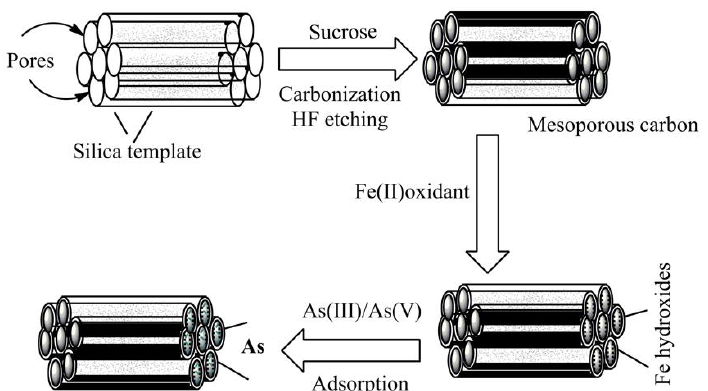
Figure 5. A graphical model for the preparation of carbon-based adsorbents and their application in arsenic adsorption. Silica has been used as the template for the synthesis of mesoporous carbon by carbonization followed by iron coating for the removal of metal ions from drinking water.